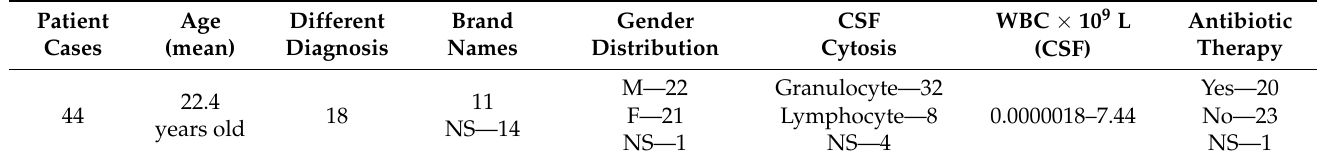
Table 2. Overview of documented IVIG-related aseptic meningitis cases in the years